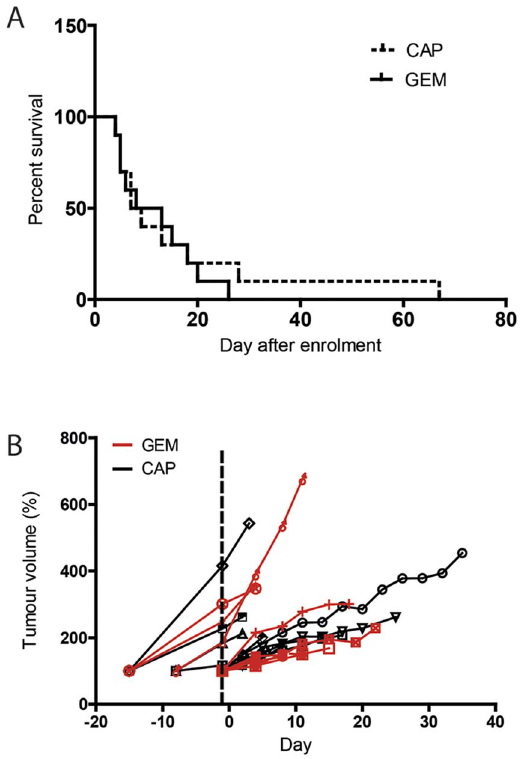
Figure 4. Comparison of CAP and GEM on KPC mice survival. (A): Kaplan-Meier curves for capecitabine (hatched) and gemcitabine (solid) survival. P=0.61 Log-Rank test, Hazard Ratio=0.78, 95%CI 0.29 to 2.06 (n=10 per group). (B): Individual growth curves for CAP- (black) and GEM-treated tumours (red). Volumes were normalized to the volume at the day of the enrolment in the survival study.